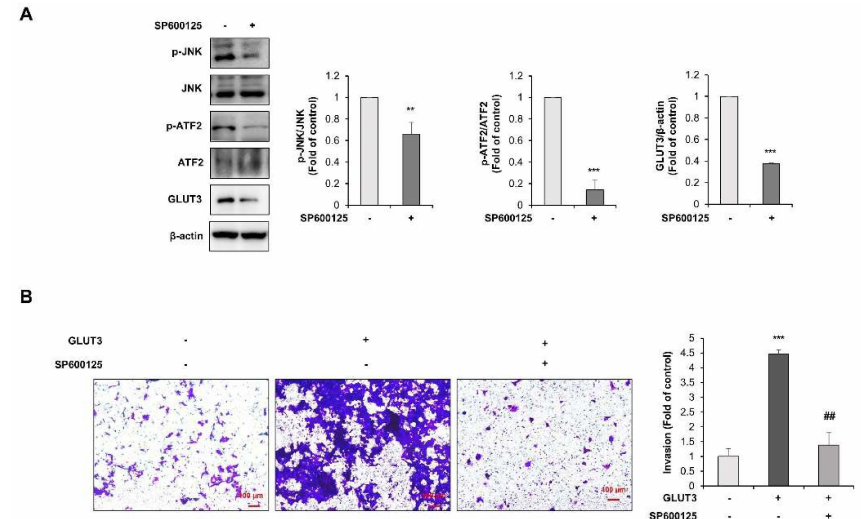
Figure 6. JNK is an upstream kinase regulating ATF2 in GLUT3-induced EMT in CRC cells. ( A ) Lysates of the HCT116 cells treated or not with SP600125 (20 µ M) for 24 h. Western blot analysis was conducted for measuring the protein levels of p-JNK, JNK, p-ATF2, ATF2 and GLUT3. ( B ) Cell invasion was analyzed after 24 h post transfection with GLUT3/pEJ-3HA (2 µ g) and treated or not with SP600125 (20 µ M) for 24 h to allow for the permeabilization of the transwell membrane. The membrane was stained with 0.2% crystal violet. Scale bar, 100 µ m. JNK, c-Jun N-terminal ki- nase; p-JNK, phospho-JNK; ATF2, activating transcription factor-2; p-ATF2, phospho-ATF2; GLUT3, glucose transporter 3; CRC, colorectal cancer. Data are the mean ± standard deviation. Statistical significance was analyzed by analysis of variance. ** p < 0.01 and *** p < 0.001, significantly different compared with control; ## p <0.01 compared to GLUT3